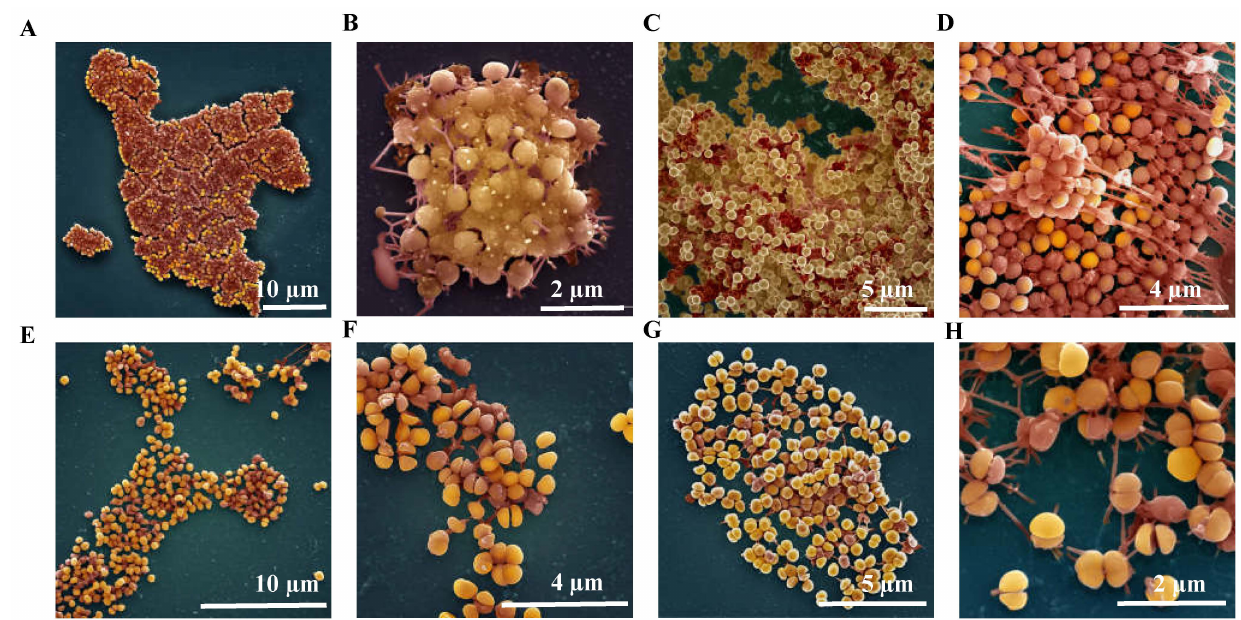
Figure 3. Biofilms of S. aureus 33 observed under scanning electron microscope. ( A , B ) Control biofilms formed after 24 h. ( C , D ) Control biofilms formed after 48 h. ( E , F ) Biofilms treated for 48 h with 16 µ g/mL AS-48. ( G , H ) Biofilms treated for 48 h with 32 µ